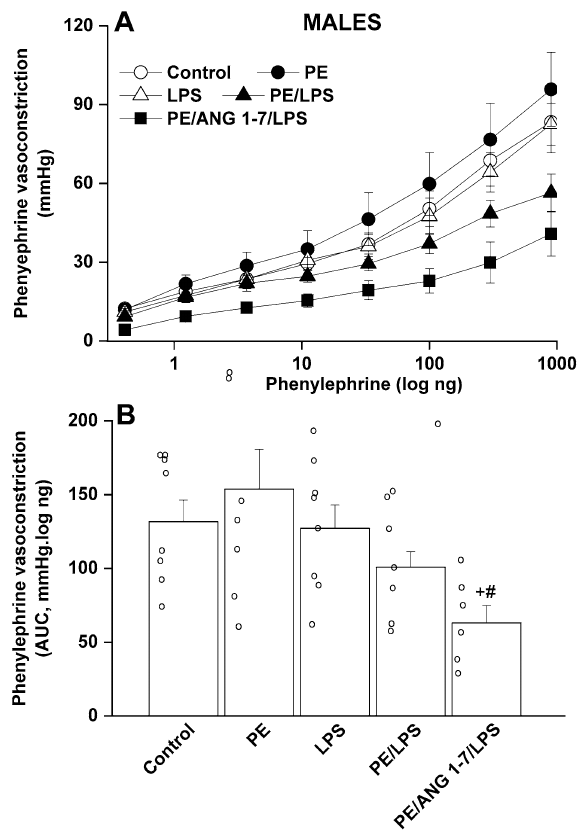
Figure 3. Effect of PE programming on the cumulative vasoconstrictor response curves of phenylephrine ( A ) and AUCs of the phenylephrine cumulative vasoconstrictor response curves ( B ) measured 4 h post LPS challenge (5 mg/kg) in isolated perfused kidneys of adult male offspring. The influence of prenatal administration of Ang1-7 is also shown. Contractile responses were estimated as changes from basal renal perfusion pressure. Values are expressed as means ± S.E.M of 7–8 measurements. ANOVA followed by the Tukey’s post hoc was utilized to measure statistical significance. + P < 0.05 vs. “PE”, # P < 0.05 vs. “PE/LPS” in the same